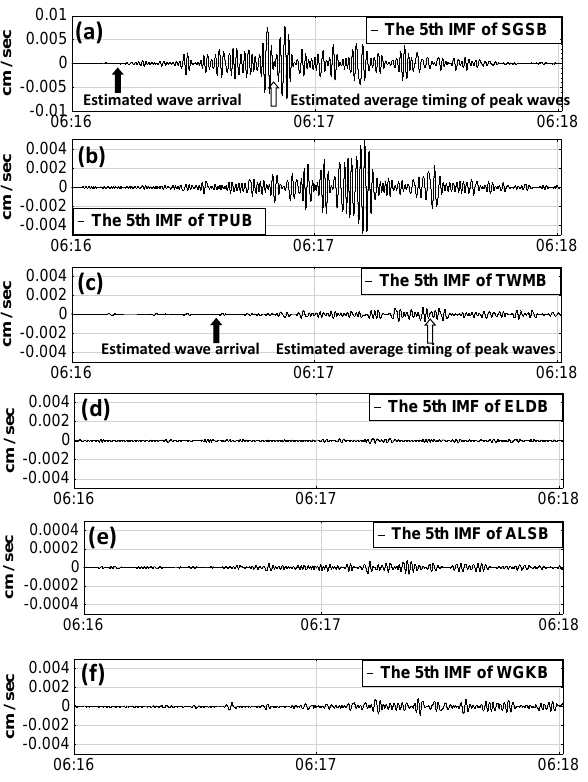
Figure 12 The IMF 5 of the vertical velocity waveforms obtained from the EMD. Fig. 12. The IMF 5 of the vertical velocity waveforms obtained from the EMD.